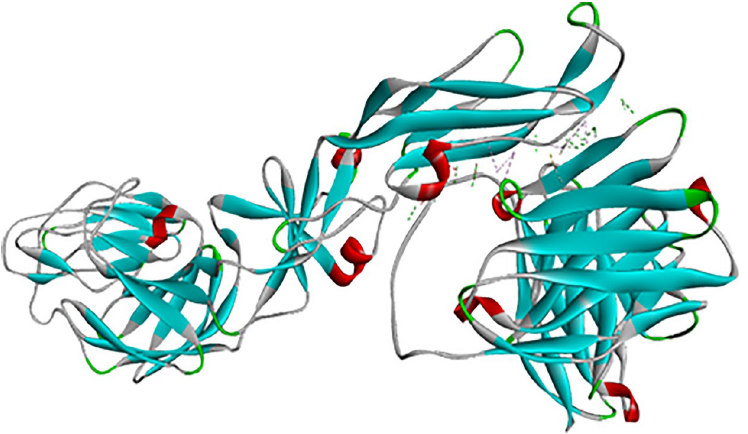
Fig 5. Interaction of scFv with dengue envelope protein. ZDock analysis showing interacting residues.